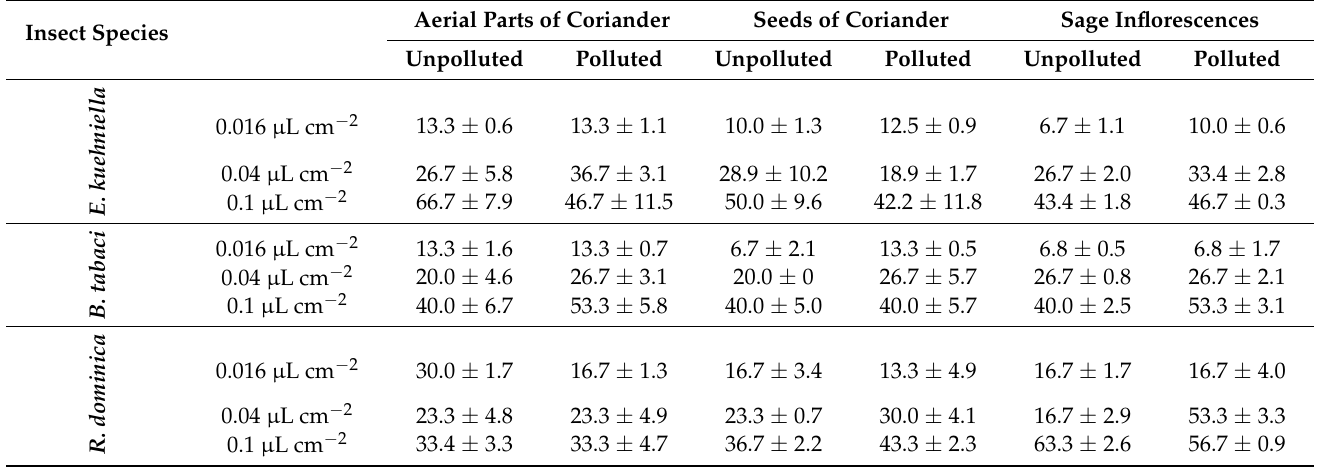
Table 4. Percentage repellency of the three different EO (sage and aerial parts and seeds of corian- der), from the two experimental plots—after 24 h of exposure—against E. kuehniella , B. tabaci and R. dominica adults. Values are means ± SE (n = 3).